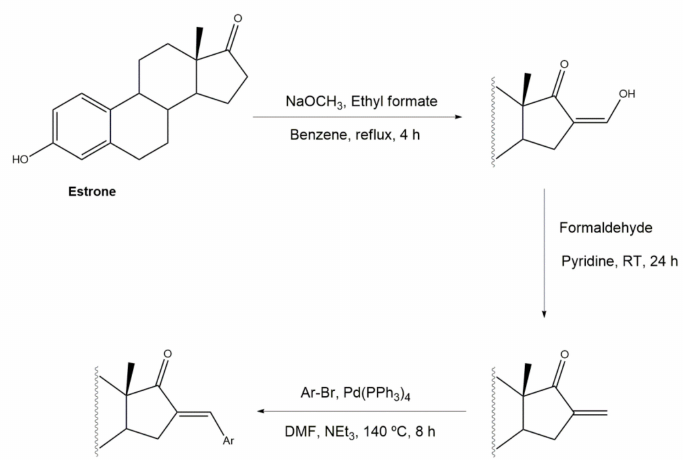
Figure 4. Alternative approach to obtain 16 E -arylidenoestrane derivatives by the employment of Mizoroki–Heck reaction